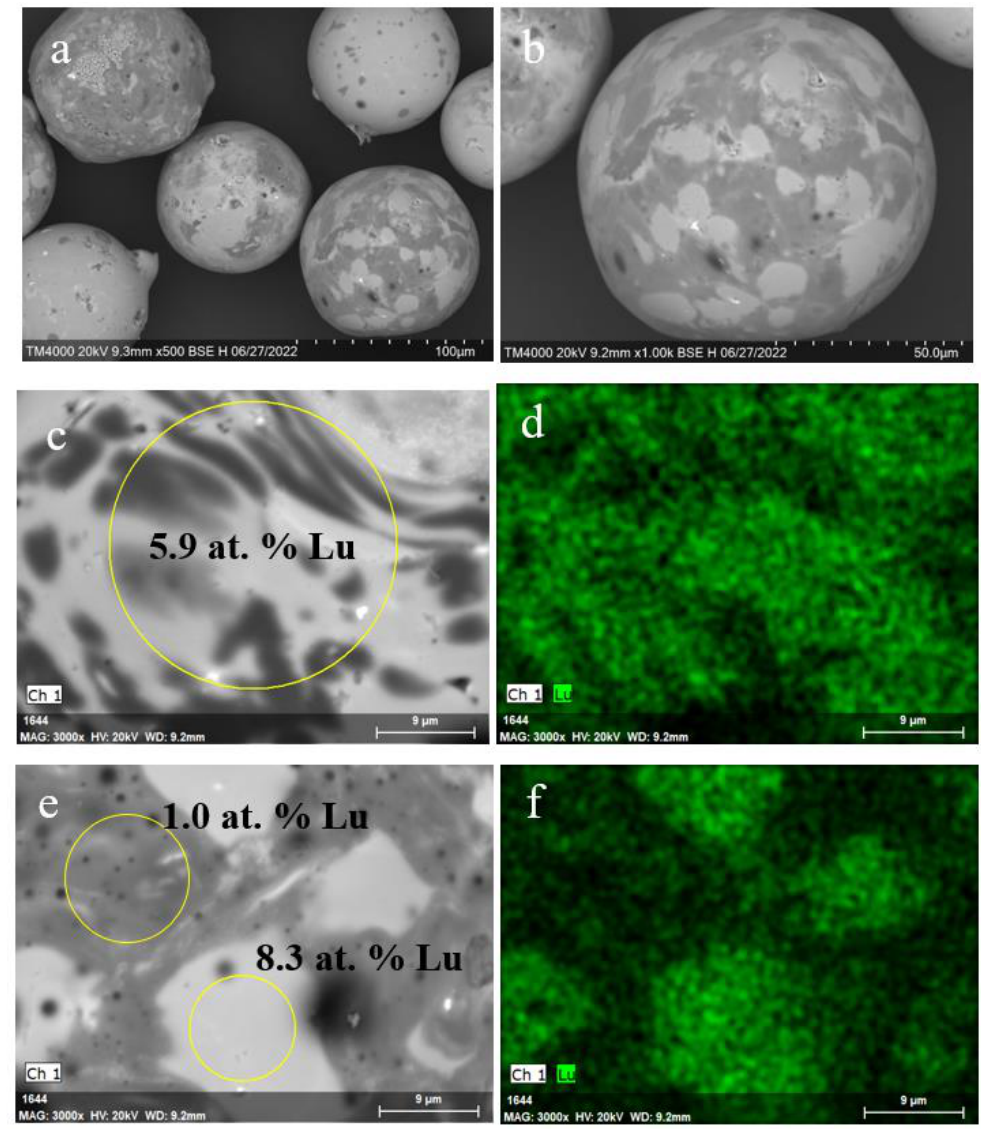
Figure 9. SEM images of the Lu 3+ loaded NaX microspheres ( a , b ) and local parts of the microsphere external surface ( c , e ) after thermal treatment at 1473 K; Lu distribution maps ( d , f ) for the local parts ( c , e ) of the microspheres.